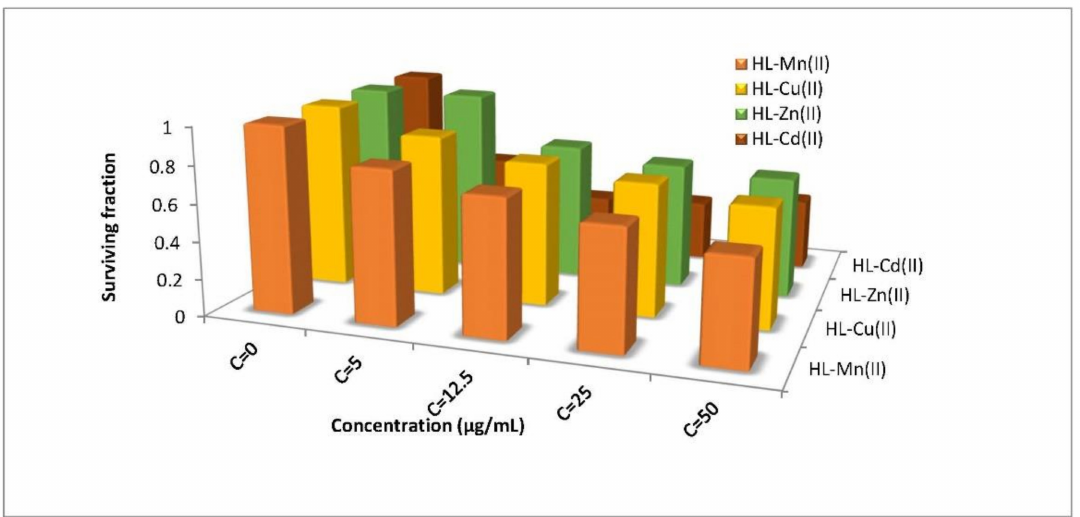
Figure 6. Anticancer activity of the free acetyl ferrocene imine ligand and some metal